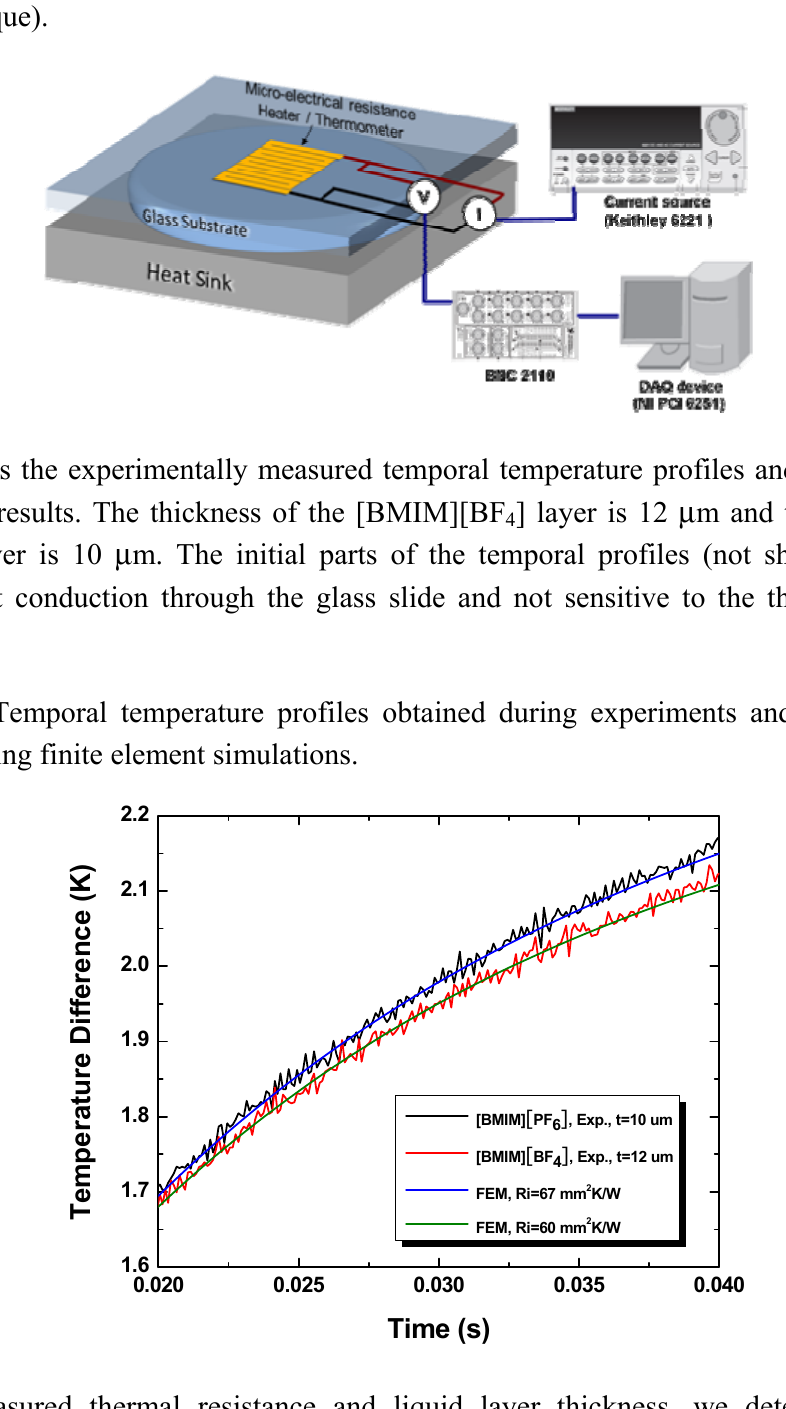
Figure 8. Schematic of the measurement setup for thermal resistance (transient hot disk technique).